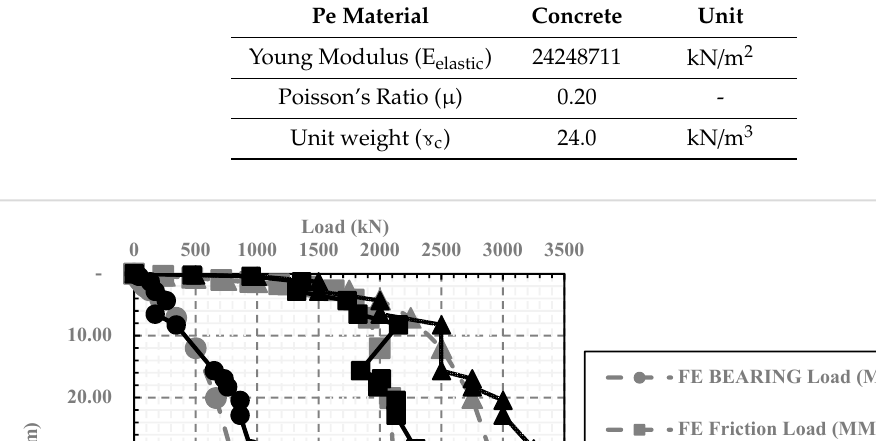
Table 2. Large diameter pile structural parameters (After [10]) .